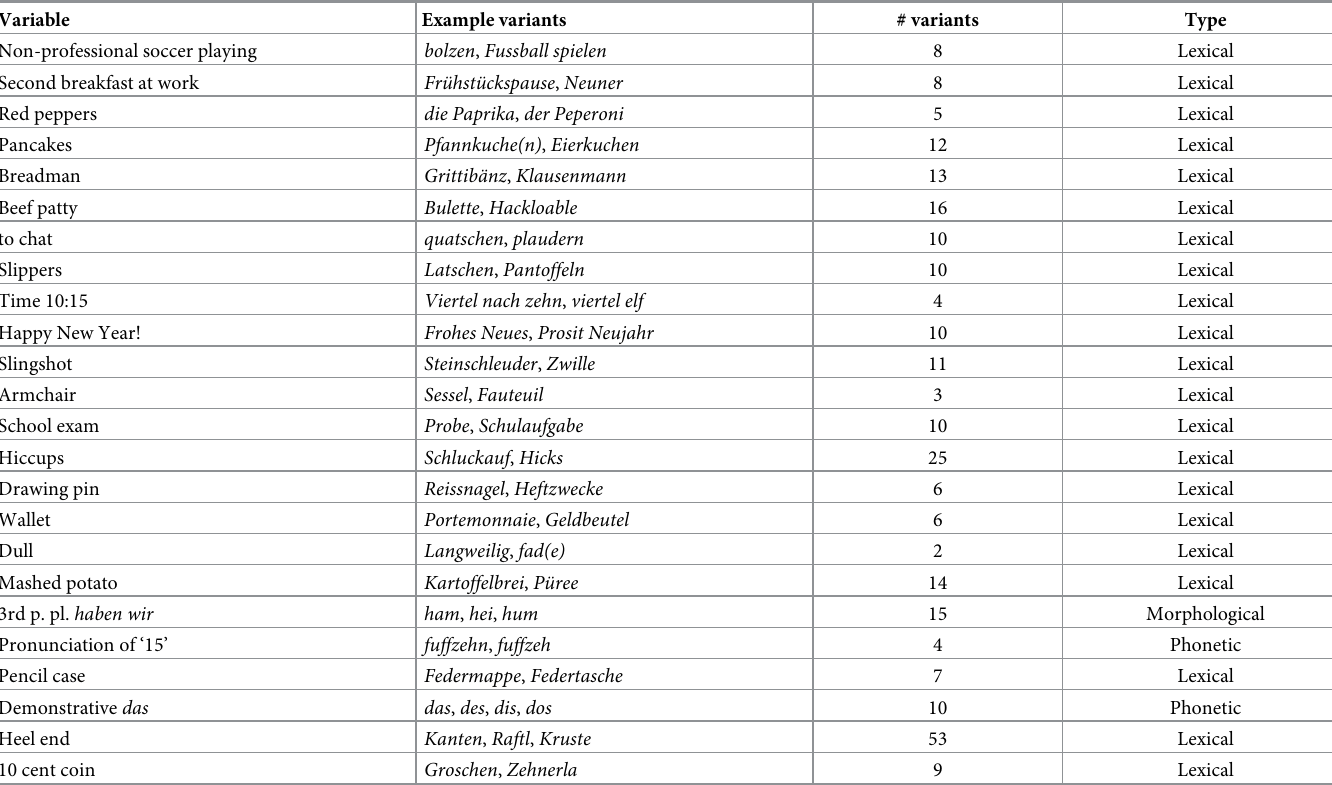
Table 1. Variables chosen for the prediction of the users’ regional background. Variable Example